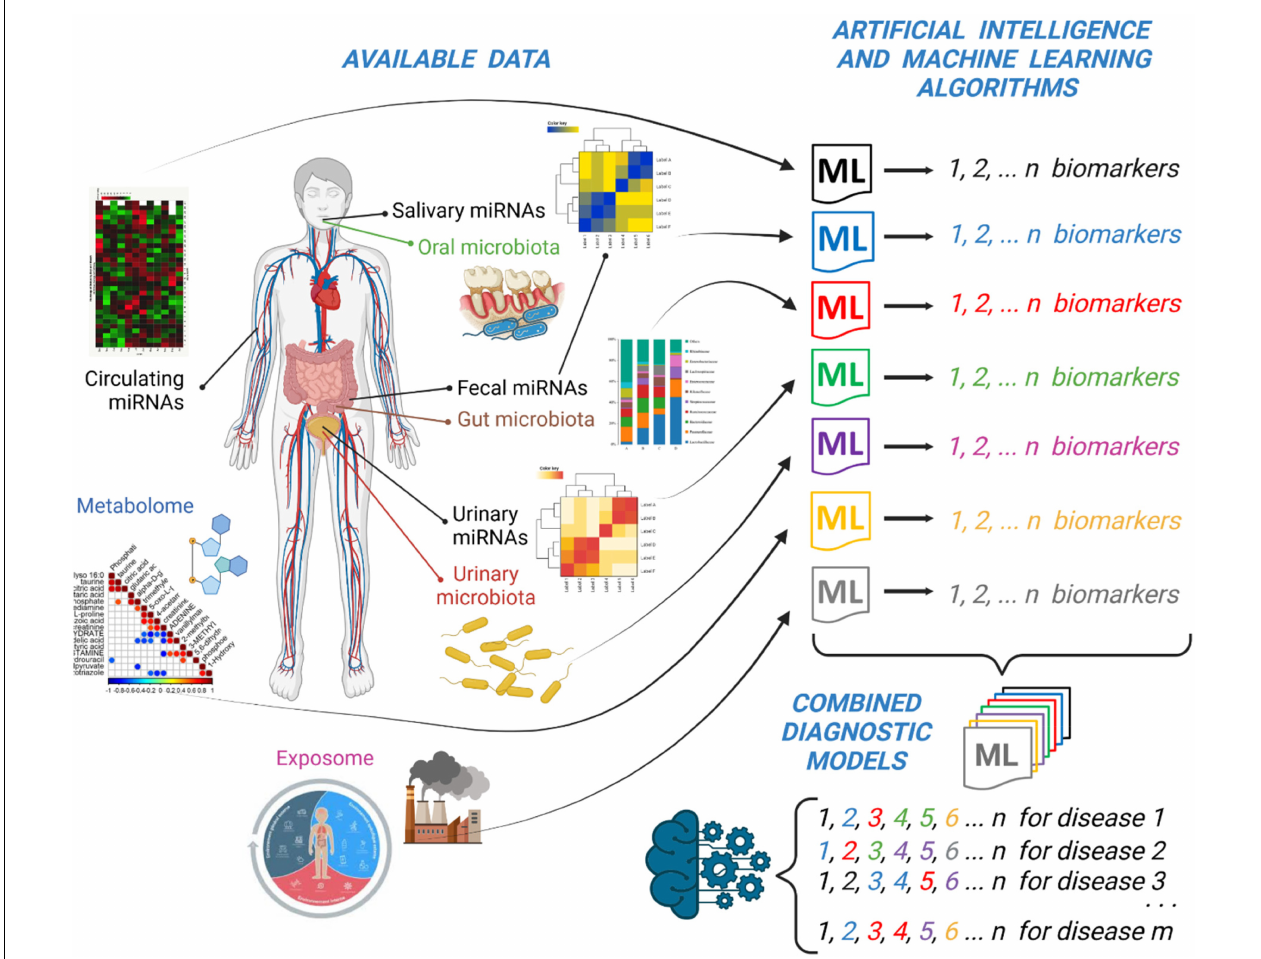
FIGURE 1 | Integration of “multiomic” data (i.e., miRNAs profiling and microbiota analysis) together with metabolomic and exposomic analysis by Artificial Intelligence (i.e., ML) algorithms can lead to the discovery of sets of specific biomarkers of disease. A general model obtained by the integration of single sets of biomarkers could improve the diagnostic and prognostic ability of specific biomarkers of disease. This picture was created with